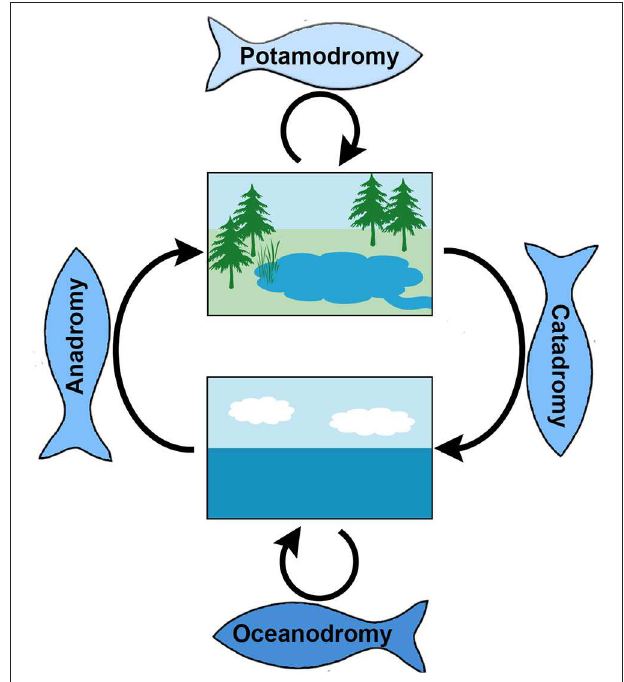
FIGURE 3 | Spawning migration modes in fish classified based on the use of biomes (freshwater vs. brackish or saline). Oceanodromous fishes live and migrate to feed and reproduce wholly in the sea (lower box). Potamodromous fishes migrate between reproductive areas and feeding grounds entirely within fresh water (upper box). Diadromous fishes migrate between fresh and salt water to complete their life cycle; these are classified as anadromous if they spend most time in freshwater but migrate to marine environments to reproduce, and as catadromous if they instead spend most time in the sea and migrate into freshwater to reproduce. The figure was created in Adobe Photoshop CC 2015v.